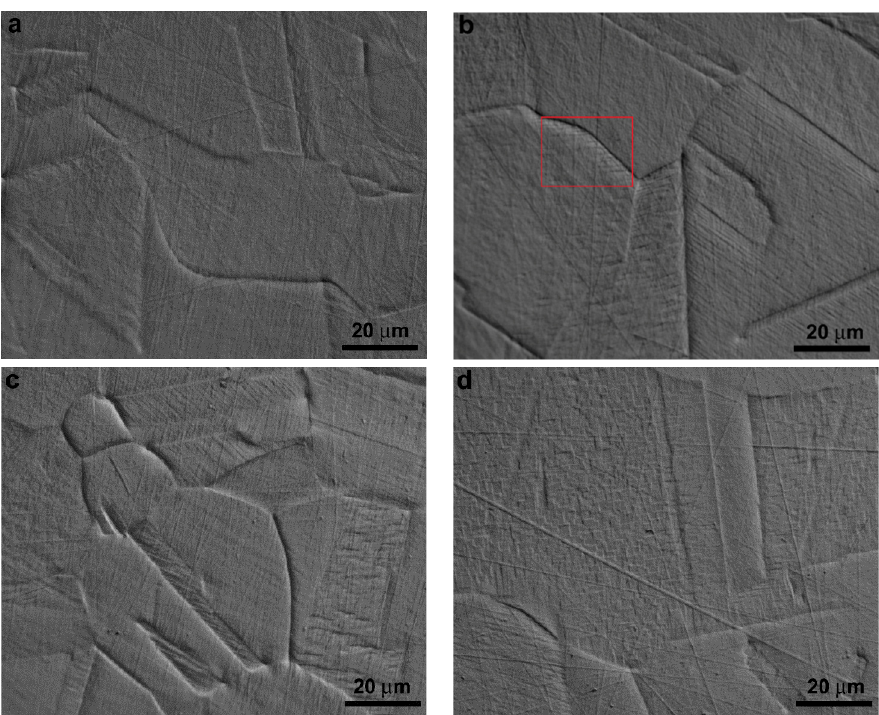
Figure 5. Surface morphology of samples nitrided at 360 °C, 50 vol.% N 2 + 50 vol.% H 2 , for 3 ( a ) and 5 ( b ) h, and at 380 °C, 3 h, with 50 vol.% N 2 + 50 vol.% H 2 ( c ) and 20 vol.% N 2 + 50 vol.% H 2 + 30 vol.% Ar ( d ). The red lined box evidences the change from a parallel pattern of the slip lines to a quadratic one.